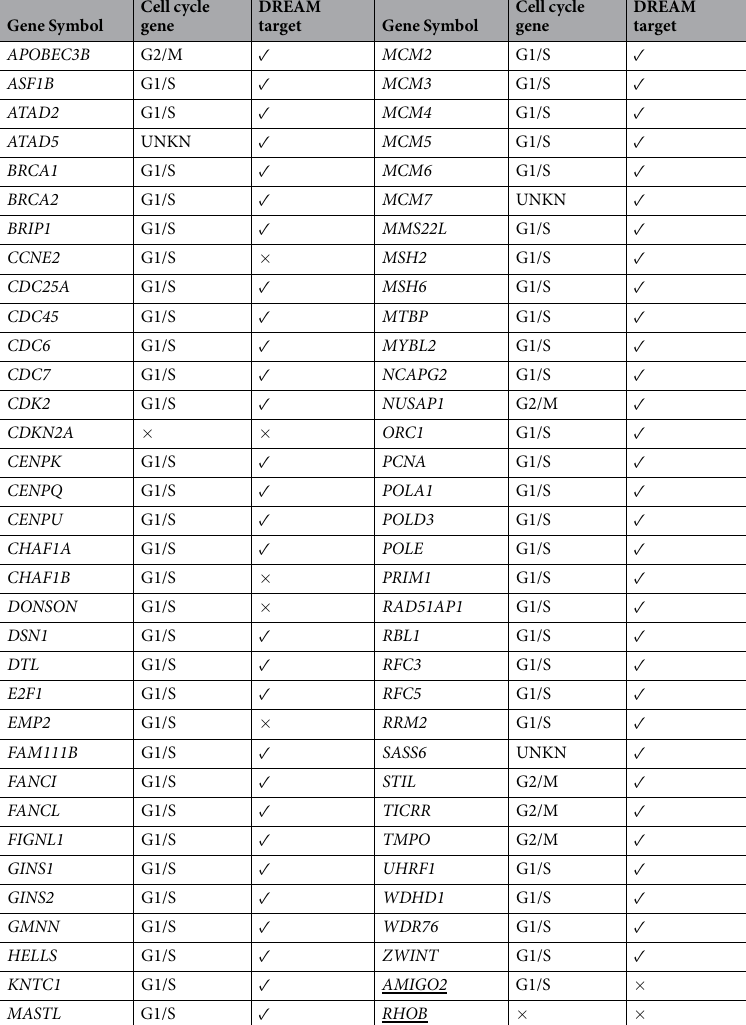
Table 1. HPV E7 deregulates DREAM target genes. 68 genes overlap in two datasets of genes deregulated upon HPV E7 expression 42, 43 . Two genes described in both datasets as downregulated are underlined. Annotation of genes as DREAM targets or cell cycle genes, including the cell cycle phase of peak expression, were extracted from Fischer et al . 23 . UNKN, timing of peak expression of the cell cycle gene is unknown; X, cell cycle- dependent expression was not reported in the